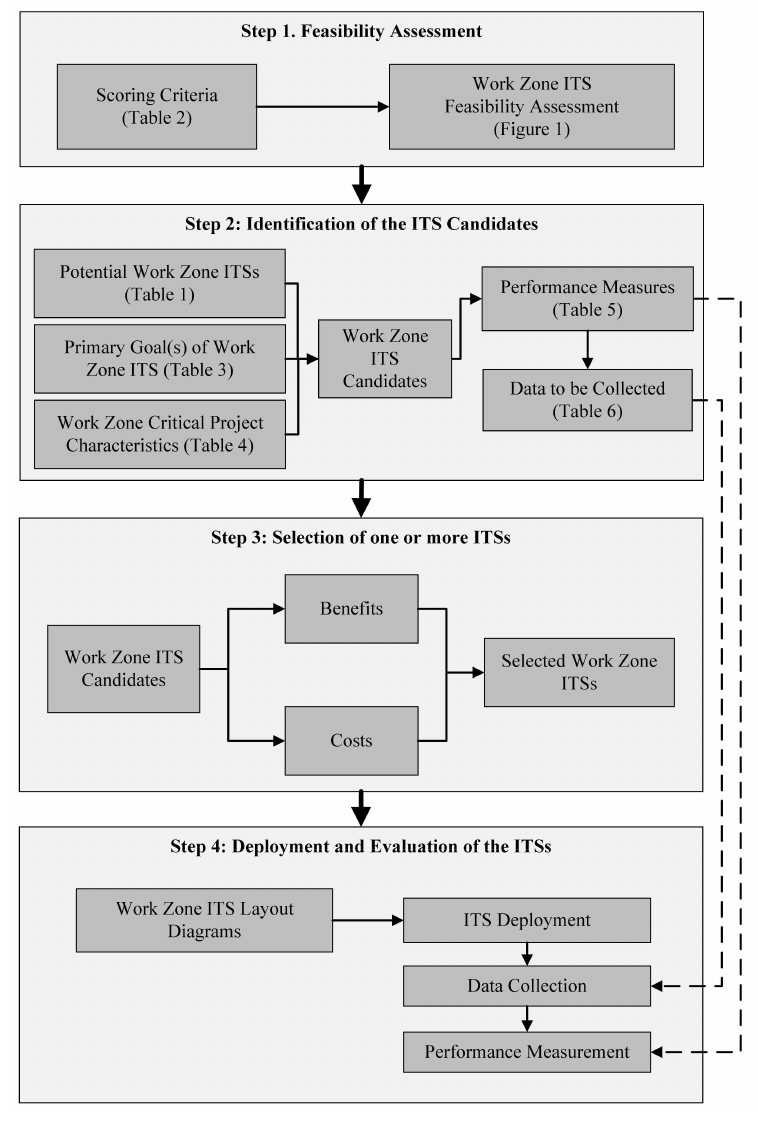
Figure 2. Framework for the selection and deployment of ITSs in a work